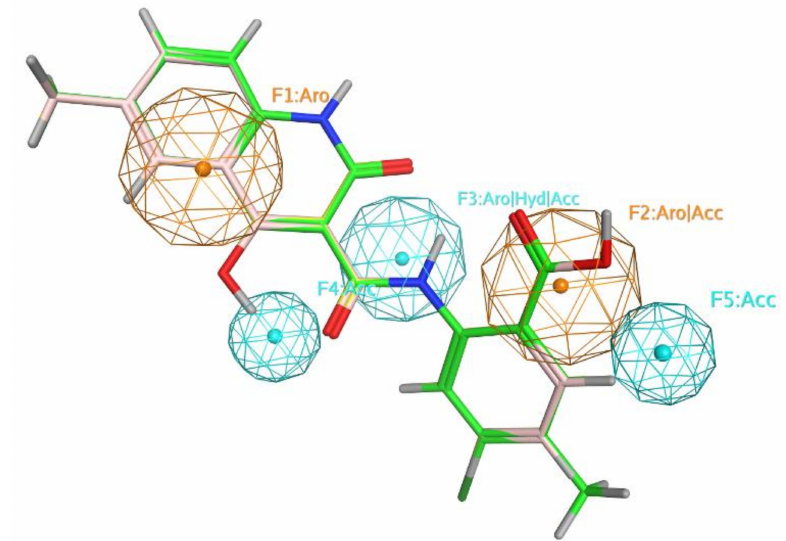
Figure 6. PI3K α active inhibitors pharmacophore model with 20 (yellow color), 24 (light pink color), and 25 (green color). Picture made by MOE